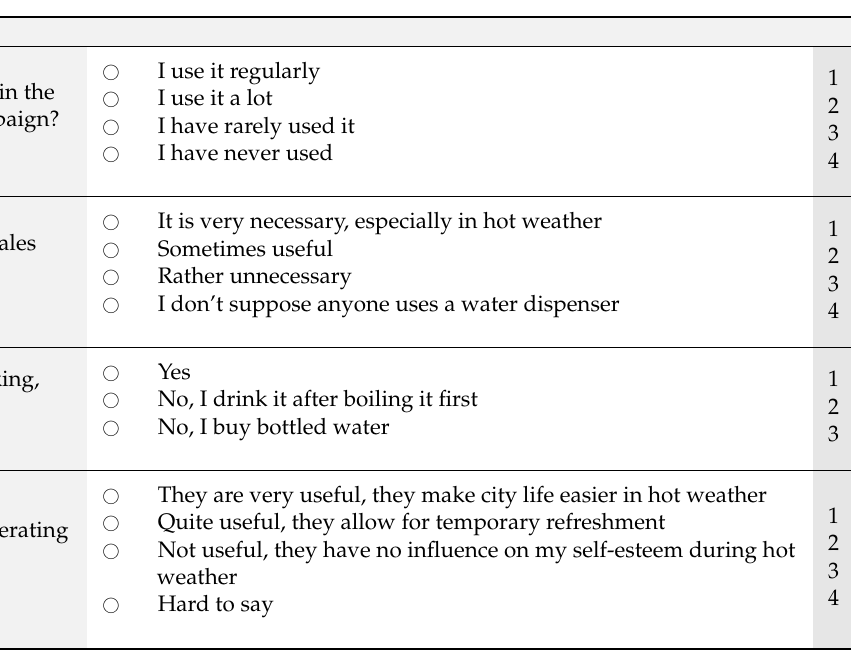
Table A1. Questionnaire